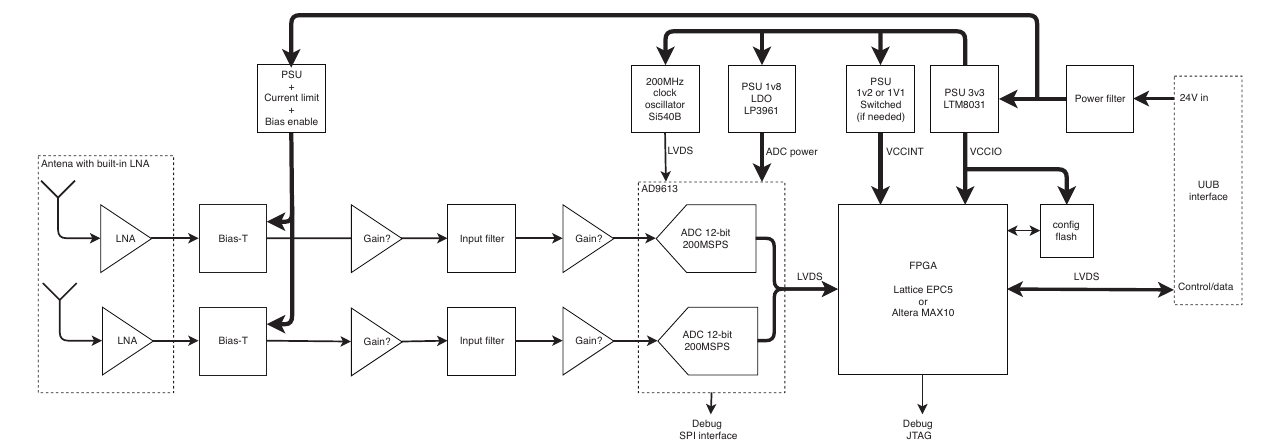
Figure 11. Block diagram of the front-end board for the radio detectors (draft – work in progress).